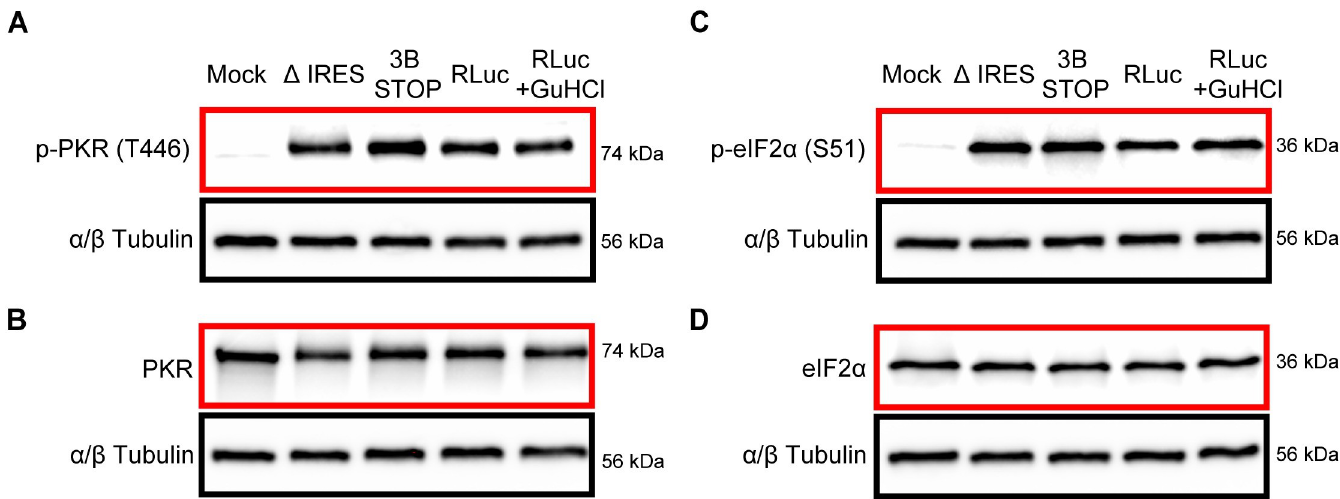
Fig 8. Activation of PKR and phosphorylation of eIF2 α phosphorylation in response to transfection of PV subgenomic replicon RNA. Western blot analysis of p- PKR (T446) (panel A ), PKR (panel B ), p-eIF2 α (S51) (panel C ), and eIF2 α (panel D ) in HeLa cell lysates. Cells were transfected individually with PV subgenomic replicon RNAs: Δ IRES, 3B STOP, and WT or with WT in the presence of 3 mM GuHCl (WT_GuHCl). Six hours posttransfection, cells were processed for western blot analysis and probed using anti-p-PKR (T446), PKR, p-eIF2 α (S51), and eIF2 α antibodies; α / β tubulin was used as a loading control. Blots provided in Supporting information (S1 Raw Images). GuHCl, guanidine hydrochloride; PKR, RNA-activated protein kinase; PV, poliovirus; T446, threonine-446; WT, wild-type.